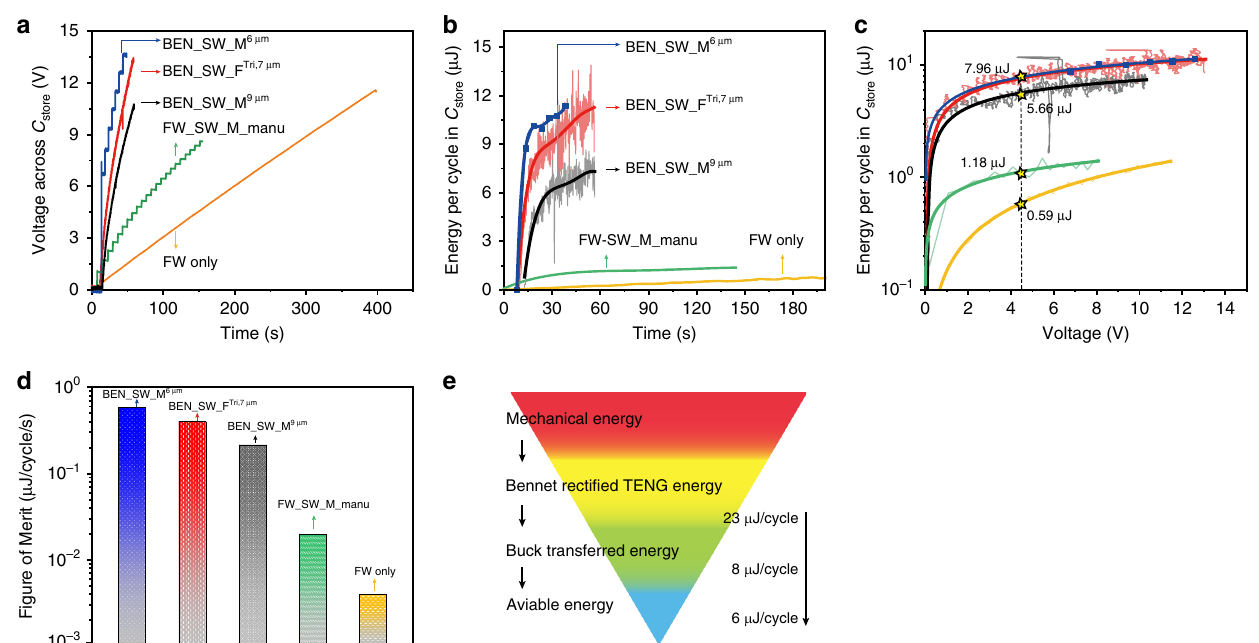
Fig. 5 Electrical performance comparisons between different methods. a Voltage curves of charging a capacitor of 22 μ F with different conditioning methods, including the methods of: a 2-stage system using a movable switch with gap 6 μ m (BEN_SW_M 6 μ m ); a, using a movable switch with gap 9 μ m (BEN_SW_M 9 μ m ), using a fi xed fl at switch (BEN_SW_F Tri,7 μ m ), using manually fabricated full-hysteresis switch and FW recti fi er (FW_SW_M_manu) 39 ; and a classical 1-stage system using only one full-wave recti fi er (FW_only). b Comparisons of the calculated energy per cycle versus time with different conditioning methods. c Comparisons of the calculated energy per cycle versus voltage under different conditioning methods. d Comparisons of the calculated Figure of Merit (FoM) at the voltage of 4.5 V. e Energy transfer fl ow. Source data are provided as a Source data fi